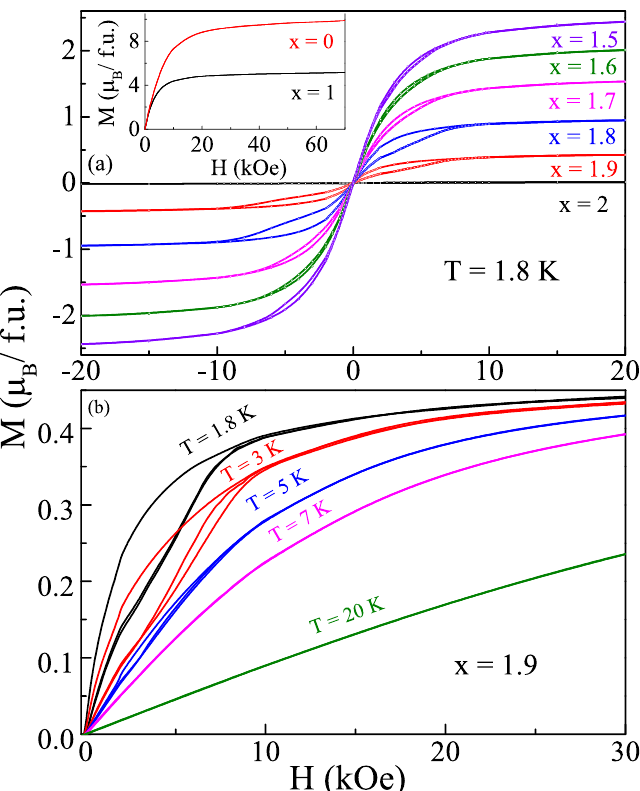
Figure 4. ( a ) Isothermal Magnetization M(H) of Dy 2 − x La x Zr 2 O 7 ; x = 1.5, 1.6, 1.7, 1.8 and 1.9 at 1.8 K. Inset shows the isothermal magnetization at 1.8 K for x = 0, 1. ( b ) Field dependence of magnetization for Dy 0.1 La 1.9 Zr 2 O 7 at T = 1.8, 3, 5, 7 and 20